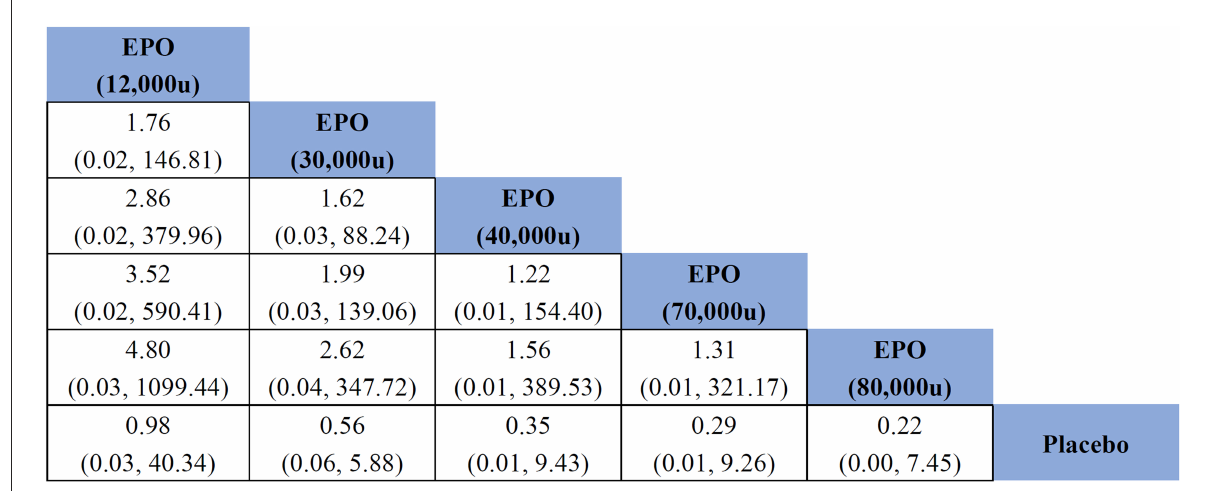
FIGURE5 Effects of different doses of erythropoietin on mortality compared with placebo based on network meta-analysis. EPO, erythropoietin; u, unit.